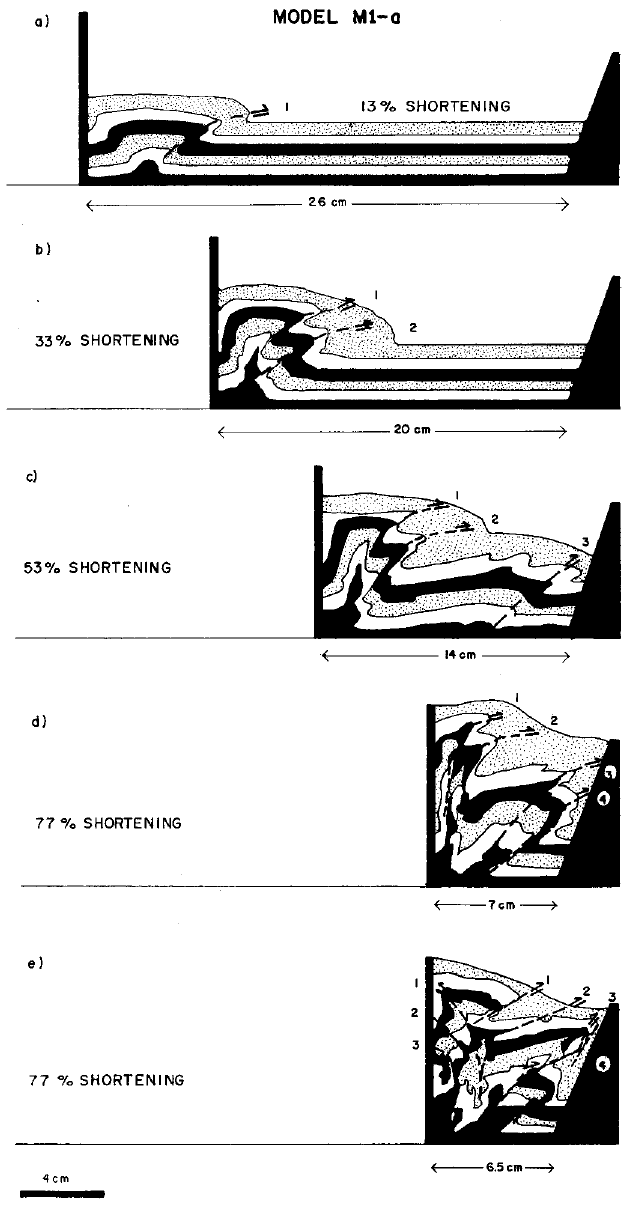
Fig. 7 – Successive stages of shortening in model M1-a (high obstacle and rigid backstop). The model evolves into an antiformal stack when the initial duplex system is further shortened. (a) to (d) are sideviews through the model wall; (e) is a section cut in the sand layers at the end of the experiment. (a) After 13% of shortening, the first thrust forms; (b) after 33%, a second thrust appears and the system becomes a duplex; (c) after 53%, a third thrust appears; (d) after 77% (final stage), the system becomes an antiformal stack; (e) final stage: cross section cut 5 cm away from the glass wall. Note the backthrusts near the rigid